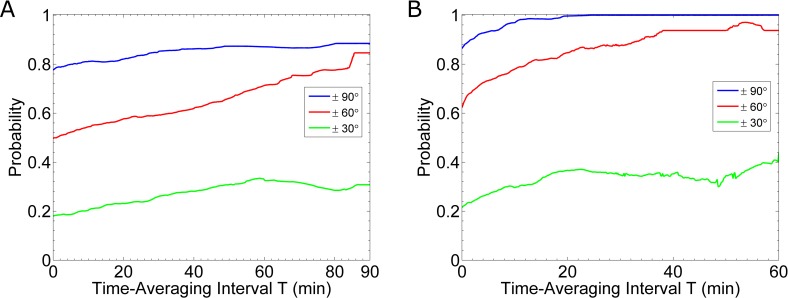
Time-averaging Gradient Prediction.Results for the probability that the cell’s prediction of the gradient is accurate within three thresholds: 90° (blue curves), 60° (red curves) and 30° (green curves). In all cases, we simulate cells in a 0.1 nM/μm gradient. (A) Results for slow binding kinetics. The curves are calculated from twenty-six simulations. (B) Results for fast binding kinetics. The curves are calculated from the same sixteen simulations used to generate Fig 6.